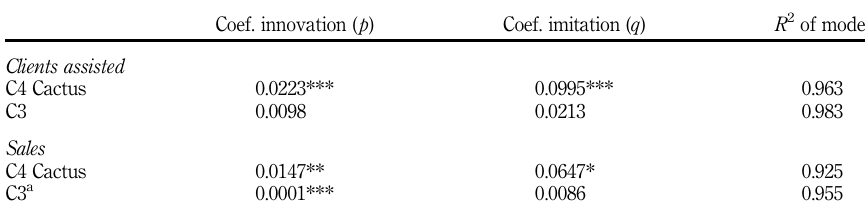
Table III. NLLS estimation